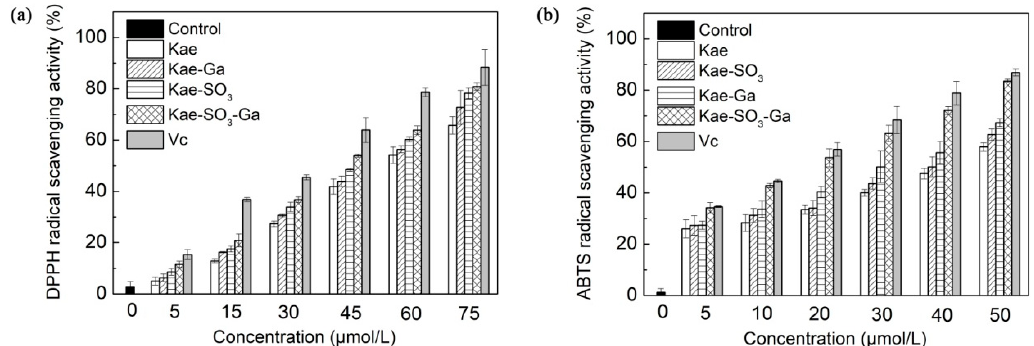
Figure 6. Effects of Kae-based compounds on ( a ) α , α -diphenyl- β -picrylhydrazyl (DPPH) radical scavenging activity and ( b ) 2,2’-azino-bis (3-ethylbenzo-thiazoline-6-sulfonic acid) diammonium salt (ABTS) radical scavenging activity. L-Ascorbic acid (Vc) as standard radical scavenger. Water-soluble Kae-SO 3 , Kae-SO 3 -Ga and Vc were dissolved in phosphate buffered saline (PBS) solution, respectively, while others in ethanol. Data was expressed as means ± SD obtained in three independent experiments. Significant difference was found from Kae derivative groups and Vc group to the control ( p < 0.05). Table 6. ( a ) DPPH free radical scavenging ratio of different concentrations of Kae-based compounds. ( b ) ABTS free radical scavenging ratio of different concentrations of Kae-based compounds.